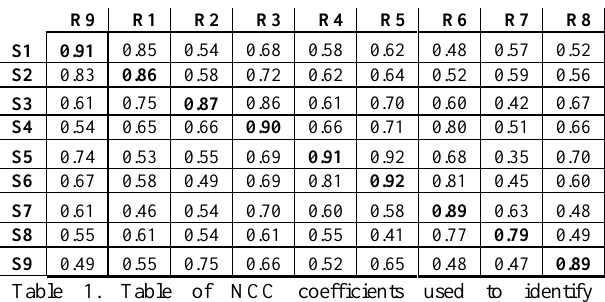
corresponding Vertical Line Features from the input panoramic image and synthetic panoramic image captured in Room B1.